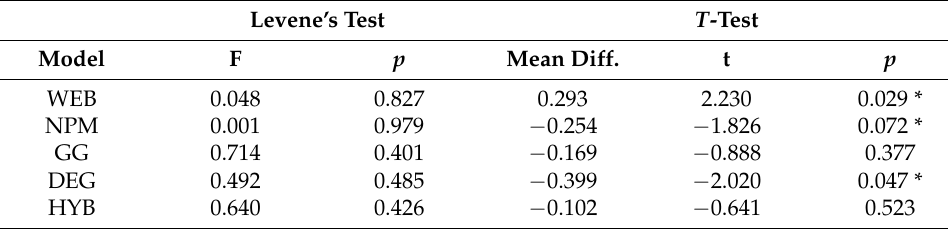
Table 4. The results of Levene’s test for equality of variances and t -test for equality of means. Levene’s Test T -Test Model F p Mean